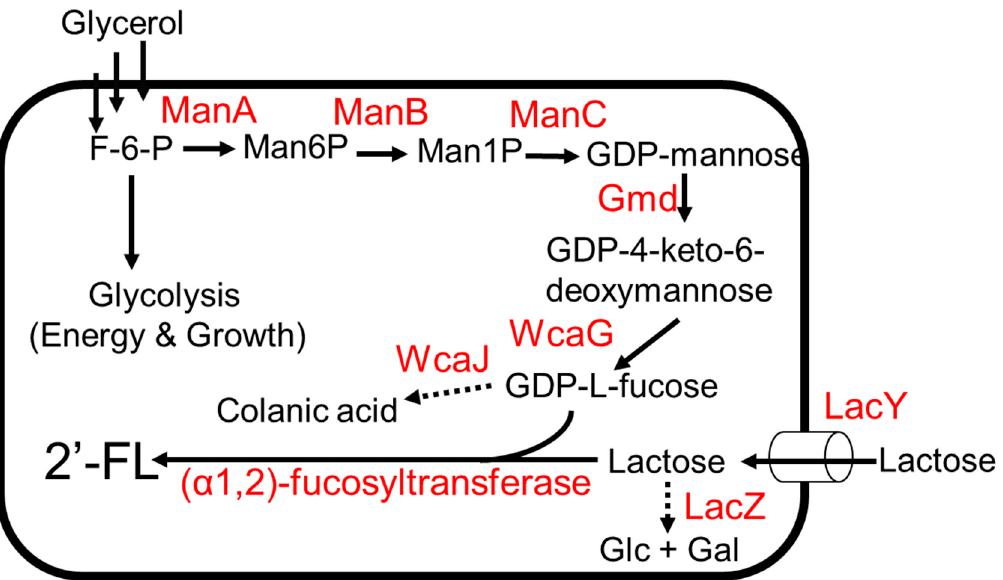
Figure 2. The 2 ′ FL production from glycerol and lactose. Dotted arrows indicate competing path- Figure 2. The 2 (cid:48) FL production from glycerol and lactose. Dotted arrows indicate competing pathways. ways. Abbreviations: ManA, mannose-6-phosphate isomerase; ManB, phosphomannomutase; Abbreviations: ManA, mannose-6-phosphate isomerase; ManB, phosphomannomutase; ManC, α - ManC, α -D-mannose-1-phosphate guanyltransferase; Gmd, GDP-D-mannose-4,6-dehyratase; D-mannose-1-phosphate guanyltransferase; Gmd, GDP-D-mannose-4,6-dehyratase; WcaG, GDP-L- WcaG, GDP-L-fucose synthetase; LacZ, β -galactosidase; WcaJ, UDP-glucose:undecaprenyl-phos- fucose synthetase; LacZ, β -galactosidase; WcaJ, UDP-glucose:undecaprenyl-phosphate glucose-1- phate glucose-1-phosphate transferase; LacY, lactose permease. phosphate transferase; LacY, lactose